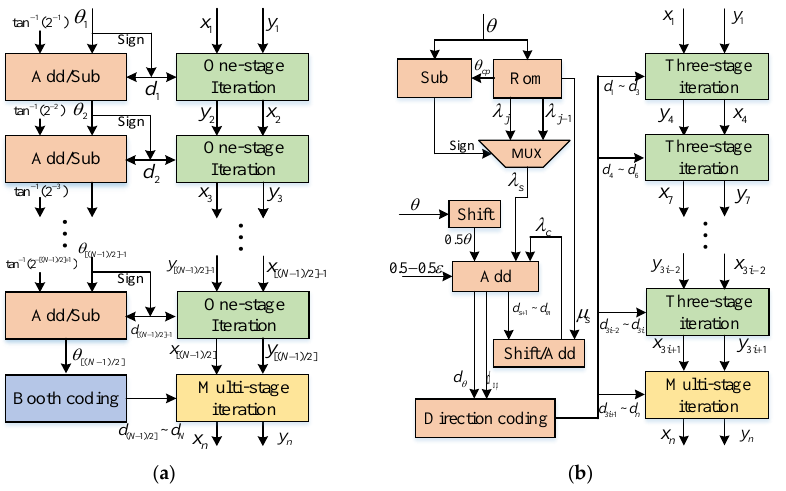
Figure 4. Structure of the classical optimized CORDIC algorithm and the RDP_CORDIC algorithm: ( a ) Classical optimized CORDIC algorithm pipeline structure; ( b ) Structure of RDP-CORDIC algo- rithm.